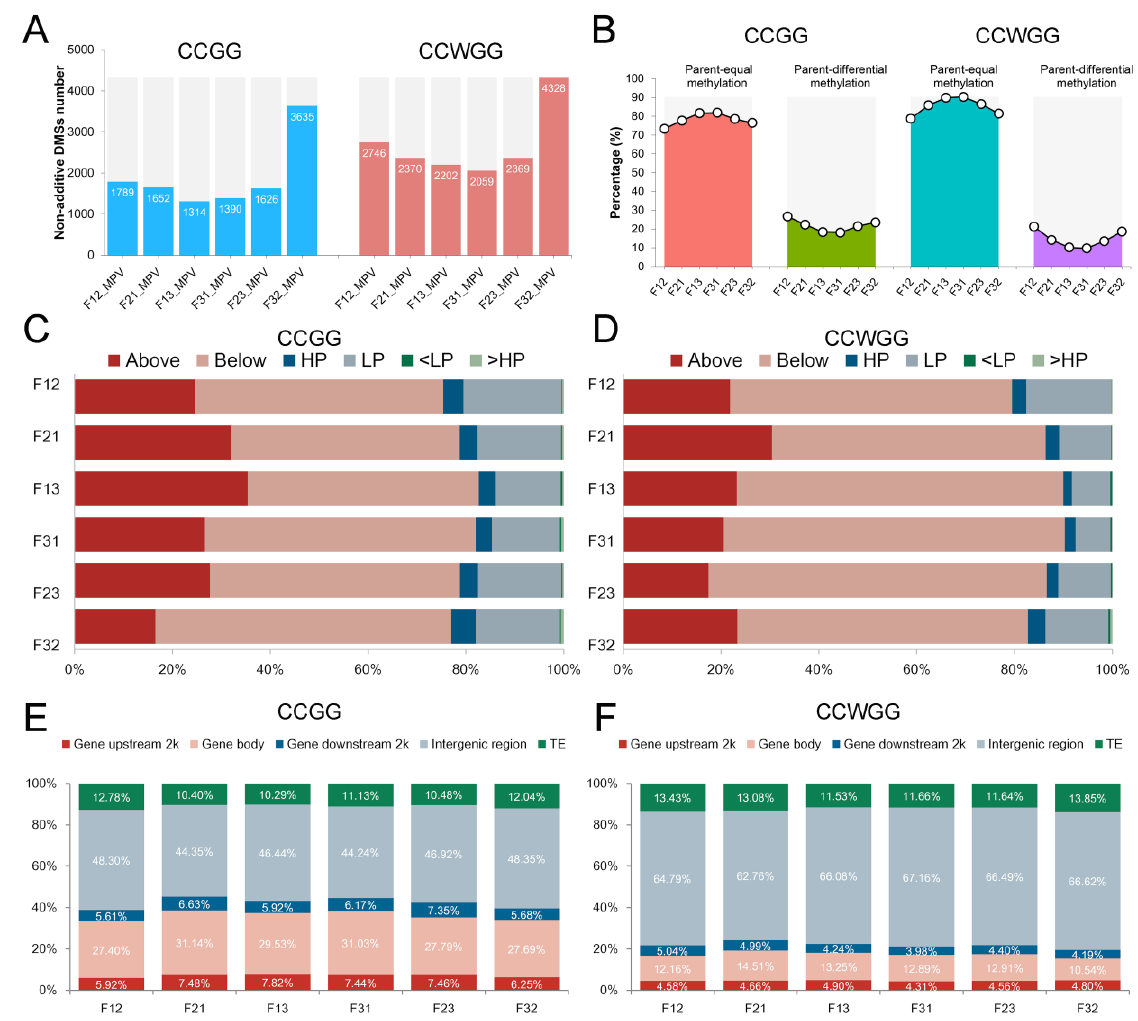
Figure 3. Non-additively methylated sites in all hybrids. ( A ) The non-additive methylation sites number of all hybrids. ( B ) Association of non-additive methylation sites with parental methylation status. ( C , D ) Non-additive categories of methylated sites in all hybrids. These sites were classified when methylation change in all hybrids is identical. “Above” or “Below” means methylation level of one hybrid is greater than two parents or less than two parents of parental equivalent regions. In parental unequal regions, “HP” or “LP” means methylation level of one hybrid is similar to the highest or lowest methylation level, “<LP” or “>HP” means methylation level of one hybrid is lower than in lowest parent or higher than in highest parent. ( E , F ) The distribution ratio of non-additive sites in three reciprocal hybrids for two methylation contexts.